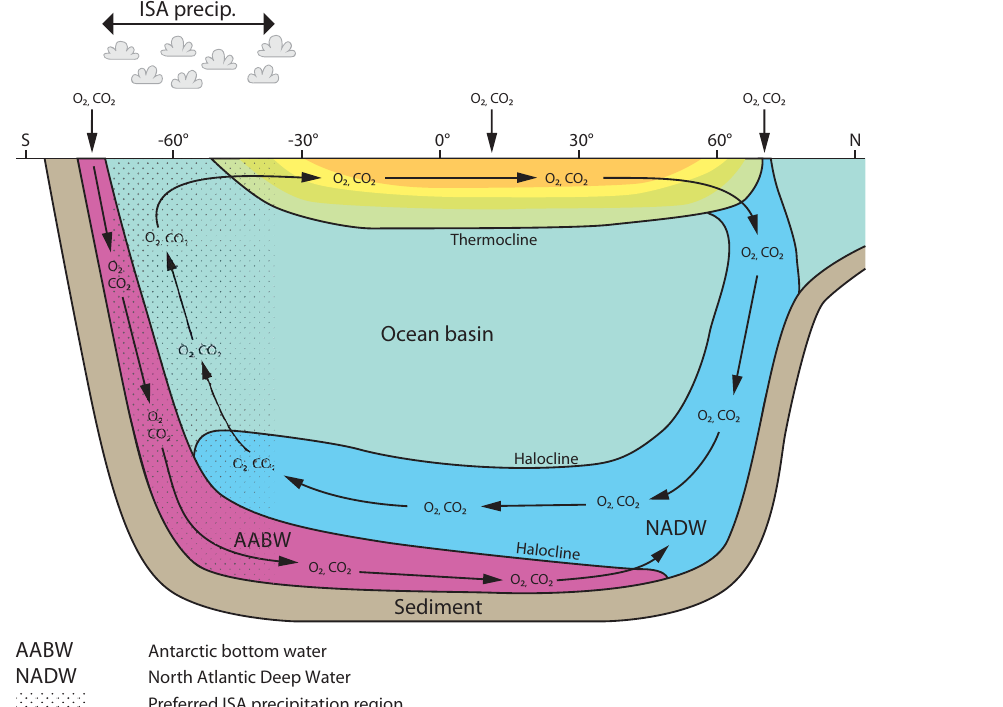
Figure 5. The motor of the Antarctic bottom water (AABW) current is the sea ice production of the Southern Ocean area bordering Antarc- tica. The North Atlantic Deep Water (NADW) current is driven by decreasing Gulf Stream temperature on its way north. Climate warming especially the faster temperature rise at higher latitudes, shifts the region of the Gulf Stream downflow and NADW further to the north, as a result of the lower (cid:49)t between equatorial and polar surface water. This shift puts additional Greenlandic coast regions in contact with warm Gulf Stream water and rising air temperatures, as another component of poor increasing amounts of fresh meltwater on the ocean surface. The rising meltwater volume and the Gulf Stream, flowing further north, increase the contact region between Gulf Stream water and fresh meltwater. This produces increasing amounts of original Gulf Stream water, which are, however, too low in density to sink and to become part of NADW. Temperature rise at higher latitudes reduces the salt content of ocean surface water around Greenland and Antarctica, inducing reduced NADW and AABW volumes. Due to the reduced downflow current volumes, the amounts of CO 2 and O 2 to the deep-ocean basin are reduced as is the vertical fertilizer transport from the ocean basin bottom to the phytoplankton at the surface.